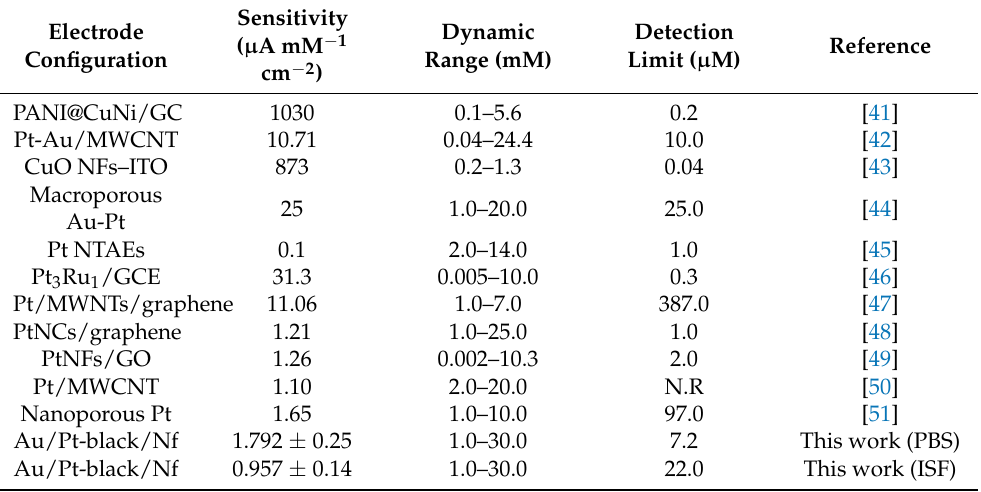
Table 2. Comparison of the analytical figures-of-the merit for the developed Au/Pt-black/Nf MNEA sensor in PBS and ISF with other reported non-enzymatic and enzymatic